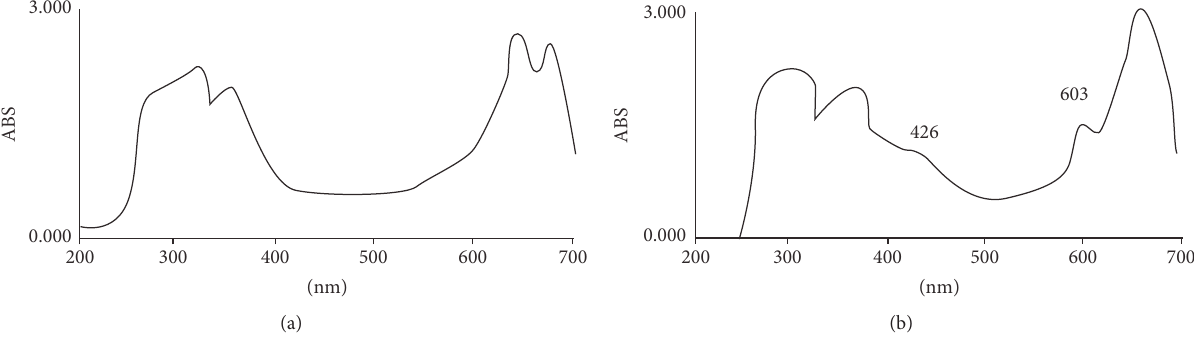
Figure 1: UV-Vis spectra of (a) FePc and (b) K[Fe III (Pc)(SCN) 2 ].